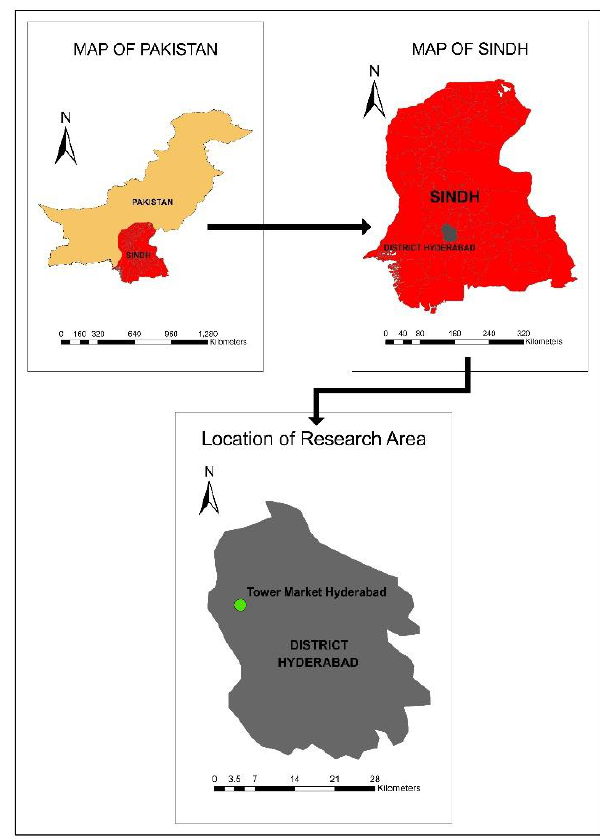
Fig. 1. Study area (source: